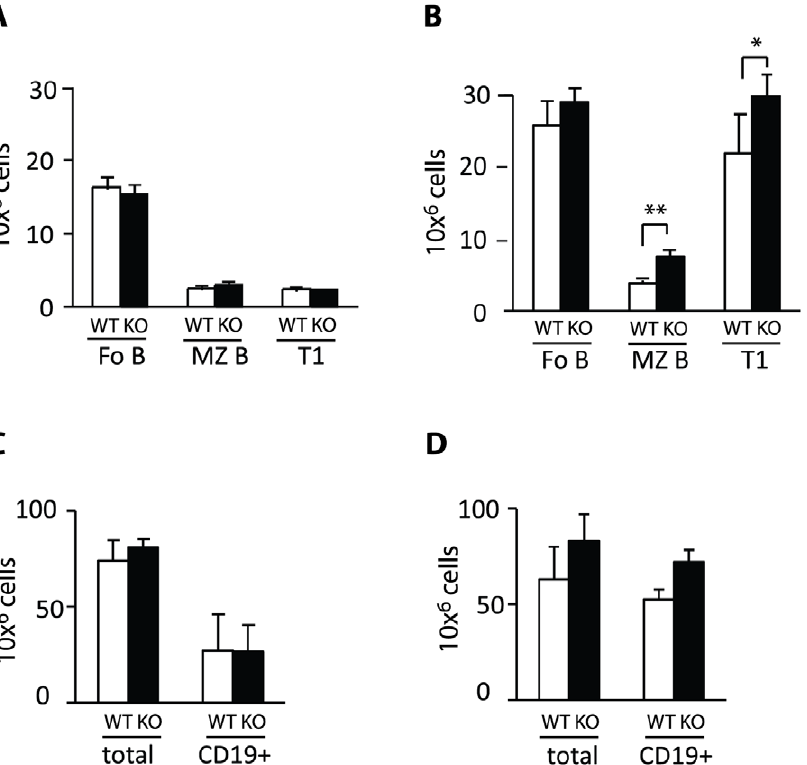
Figure 9. The MZ B cell numbers increase over time in Eps15-KO mice. A.–B. Bar graphs depicting the total number of Fo, MZ and T1 B cells in the spleen of 2 month old ( A ) and 24 month old ( B ) Eps15-WT (WT, white bars) and Eps15-KO (KO, black bars) mice. C.–D. Bar graphs depicting the total and CD19 + cell number in the spleen of 2-month-old ( A ) and 24-month-old ( B ) (Eps15-WT (WT, white bars) and Eps15-KO (KO, black bars) mice. Values are depicted as mean 6 standard error mean. N=4 per two month old and n=5 per 24 month old mice. Statistical significance was assessed using Student’s t-test and significant differences are indicated as *=p , 0.05, **=p , 0.01.